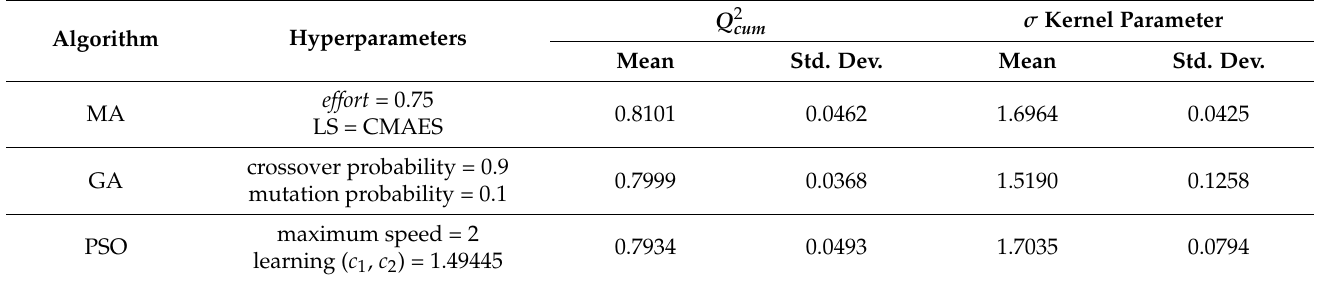
Table 4. Mean and standard deviation of Q 2 cum , σ by MA, GA and